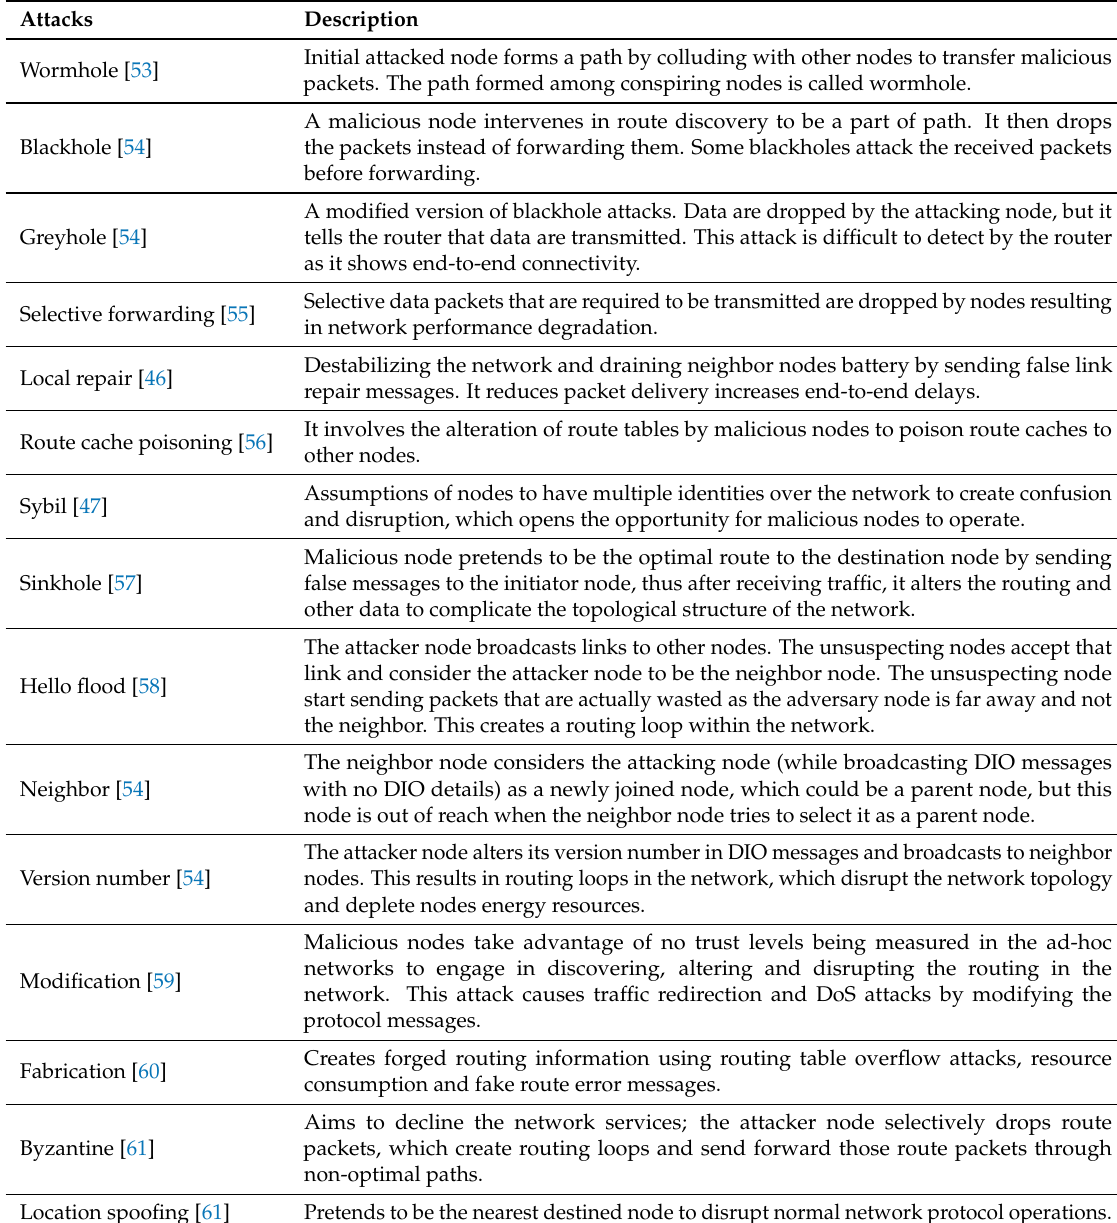
Table 2. Internal attacks on fog-based IoT